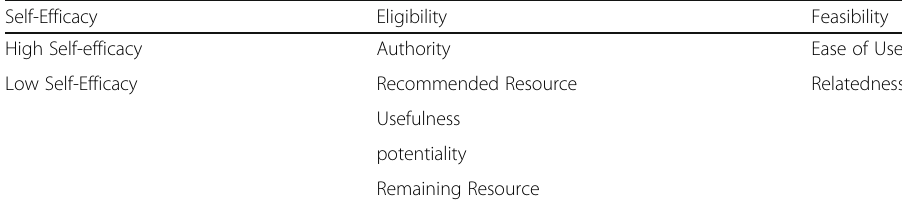
Table 3 Criteria for selecting nodes Self-Efficacy High